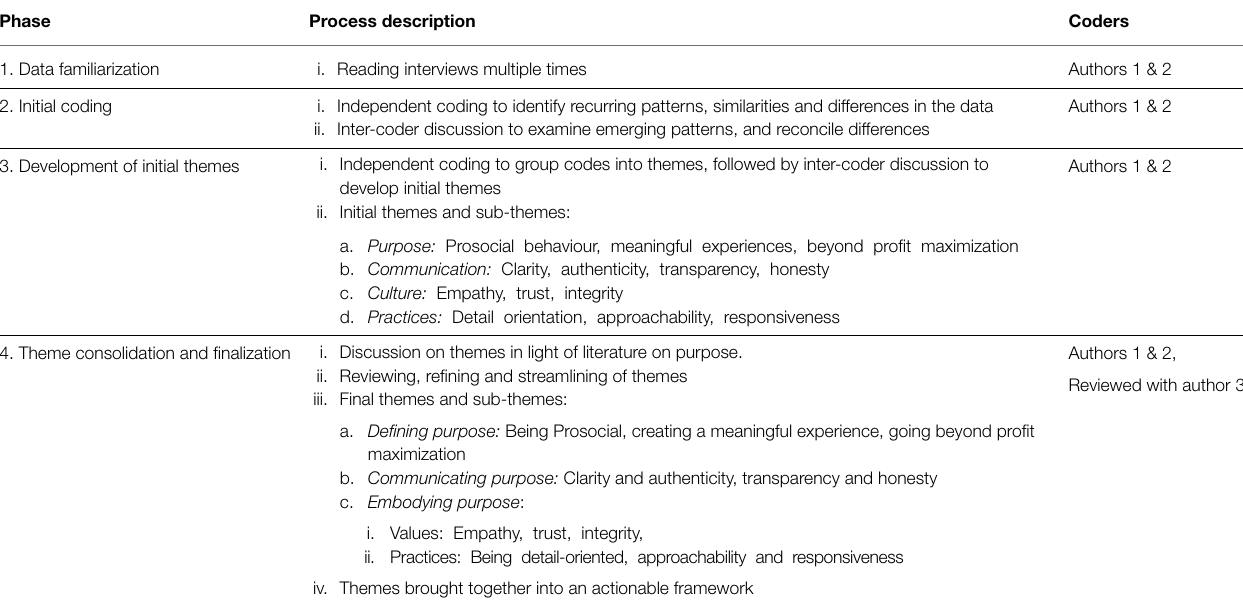
TABLE 1 | Data analysis process.